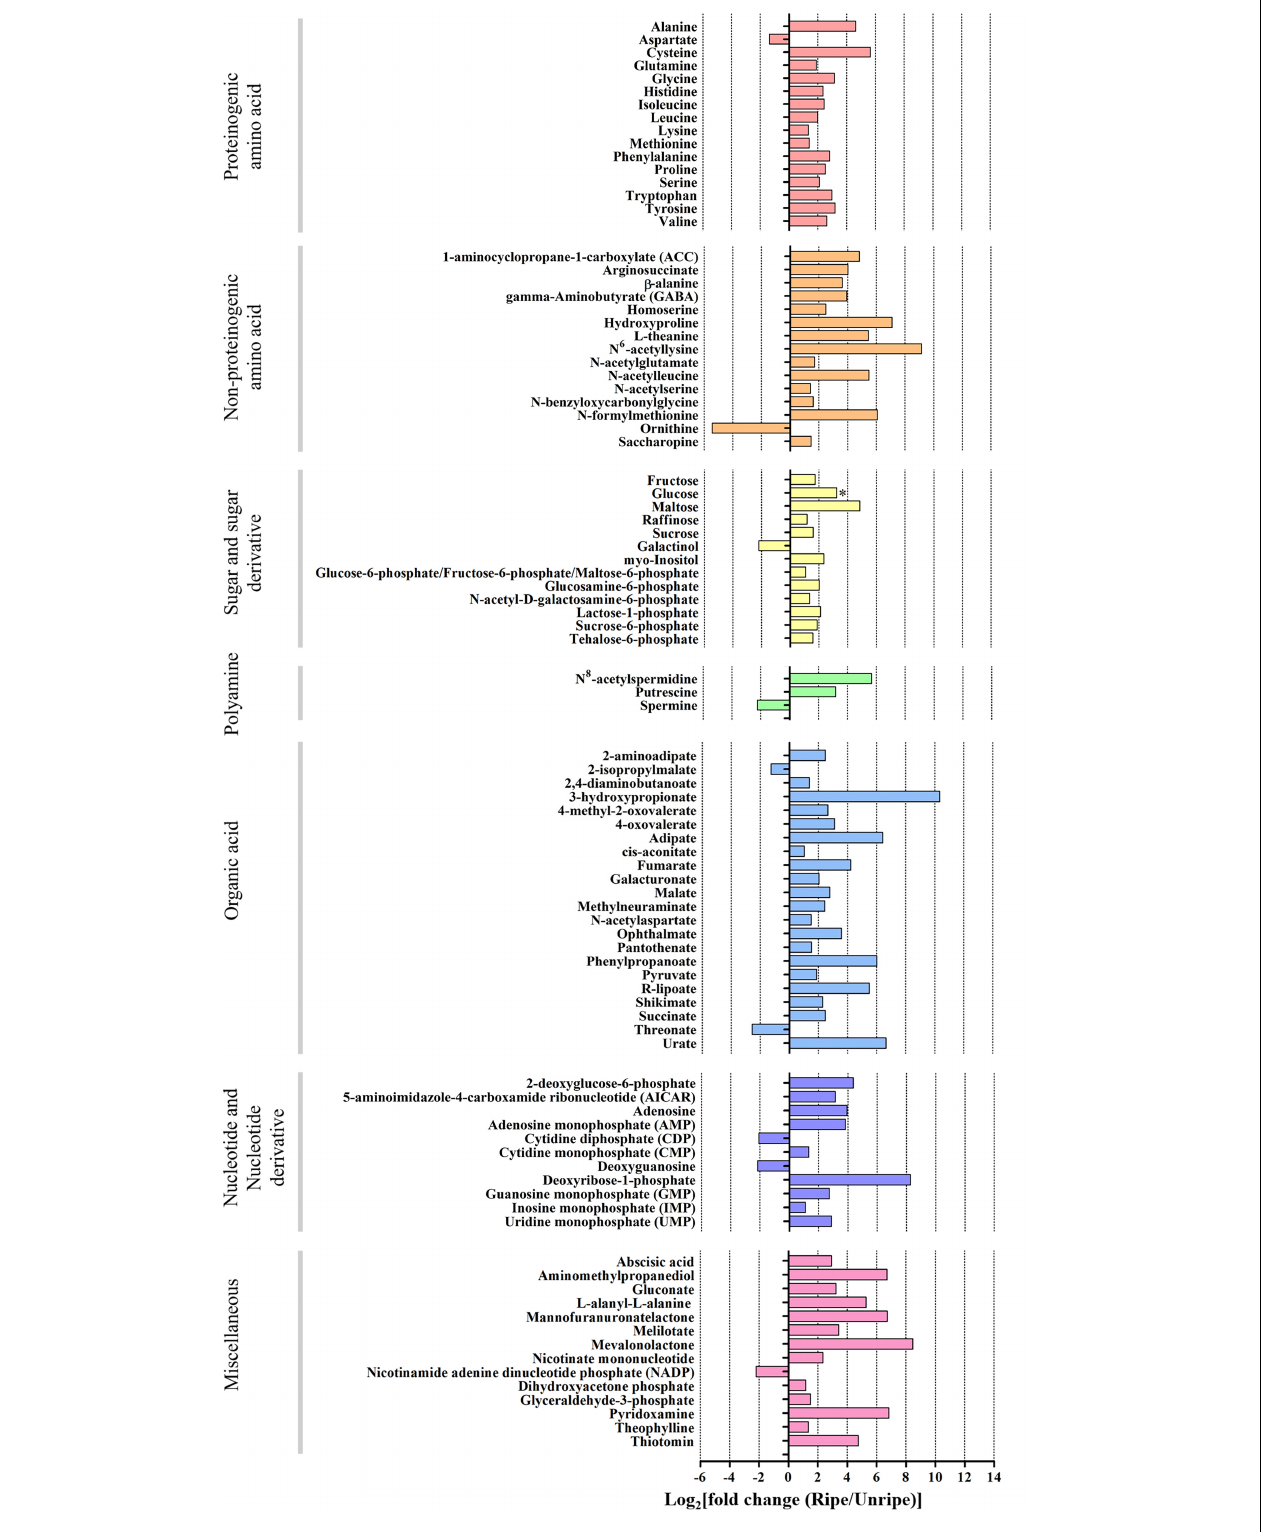
FIGURE 2 | Log 2 of fold change (FC) of metabolite intensity from ripe and unripe stages of durian cv. Monthong. Based on volcano plot (| log 2 (FC)| > 1, P < 0.05), these metabolites significantly changed during the ripening process. Changes are represented in the bar chart, indicating increased levels (positive values) or decreased levels (negative values) of the metabolite intensity. ( ∗ = glucose which is significant under P = 0.1).